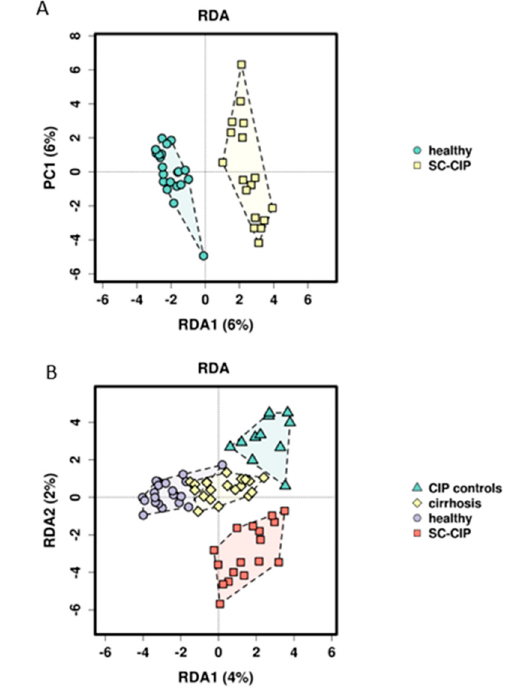
Figure 2. Redundancy analysis (RDA analysis) for beta diversity based on BrayCurtis dissimilarity on the genus level. Each point on the diagram presents one study proband. Each group is drawn in a unique color. ( A ) SC-CIP (yellow) compared to healthy (green) ( p = 0.001), and ( B ) SC-CIP (red), CIP controls (green), cirrhosis (yellow) and healthy (violet) compared to each other ( p = 0.001). Findings indicated that with RDA analysis, all four groups showed differences in beta diversity. PC = principal component.